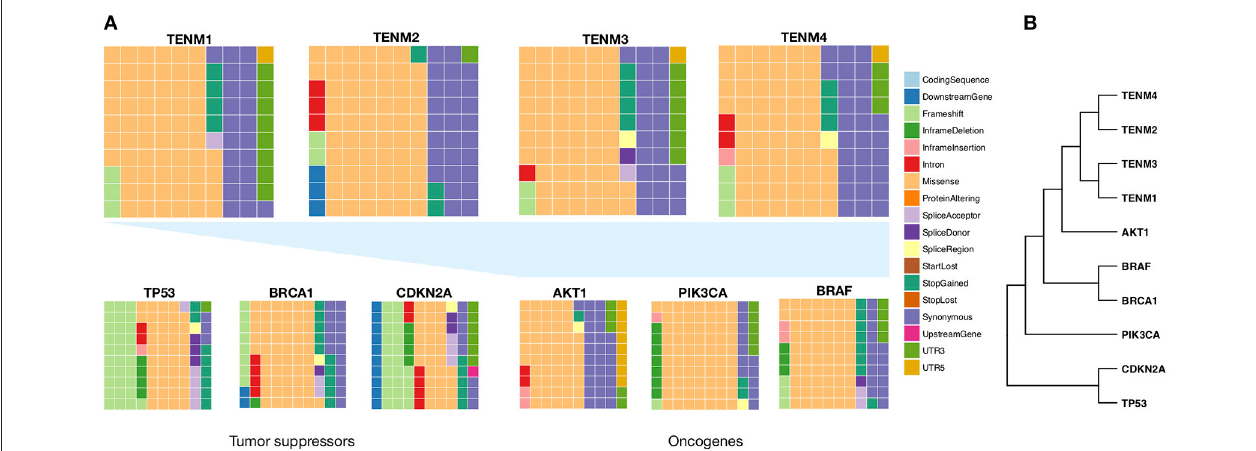
FIGURE 2 | Frequency of mutation types targeting Teneurin genes. All somatic variants reported for Teneurin genes were retrieved from the Caner Genome Atlas, without distinction of tumor type. The number of variants was 1155 for TENM1 , 777 for TENM2 , 938 for TENM3 , and 772 for TENM4 . For the remaining genes, variant numbers were 97 for AKT1 , 212 for BRAF , 385 for BRCA1 , 346 for CDKN2A , 404 for PIK3CA , and 1000 for TP53 . (A) Waffle charts describing the proportion of each mutation category. Each square represents a frequency of 1%. Waffle charts at the bottom were calculated from TCGA through the same procedure and are included for comparison. (B) Euclidean-distance cladogram grouping genes based on their mutation type frequency distribution was constructed using the R package hclust .